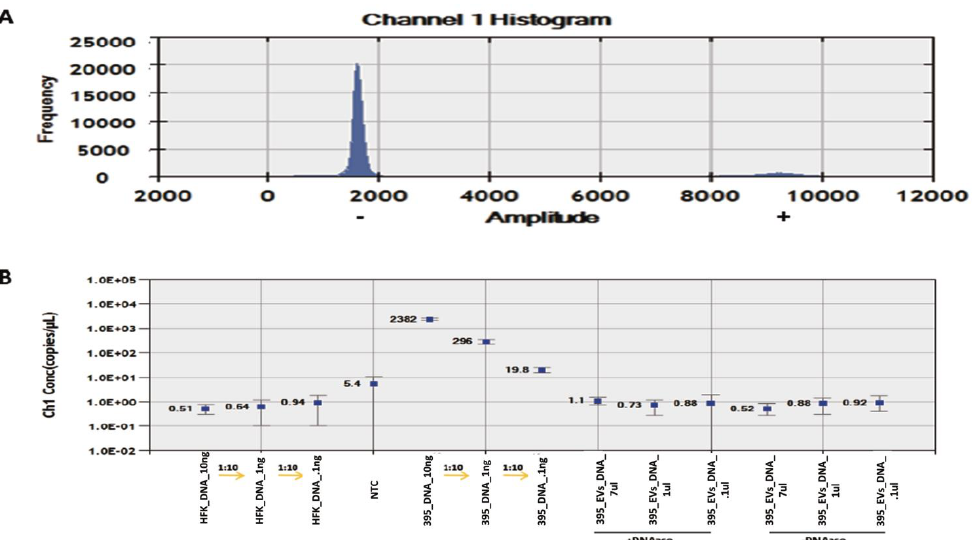
Figure 4. ddPCR detection of HPV E7 DNA in serially diluted HFK, GUMC-395, and GUMC-395 EVs. ( A ) Histogram results for droplet separation based on HPV E7 assays. Positive droplets were observed at an amplitude of about 9000, whereas negative droplets were observed at an amplitude of about 1800. ( B ) The concentrations (copies /μL) of the HPV E7 as processed by QuantaSoft. The concentration and Poisson confidence intervals for each “merged” well were computed using the QuantaSoft Software. Concentrations (copies/μL) represent the measurement of HPV E7 DNA in merged wells for each sample. Error bars indicate the Poisson 95% confidence intervals for each measurement. HFK = Human Foreskin Keratinocytes ( − HPV); GUMC-395(+HPV); NTC = No Template Control.